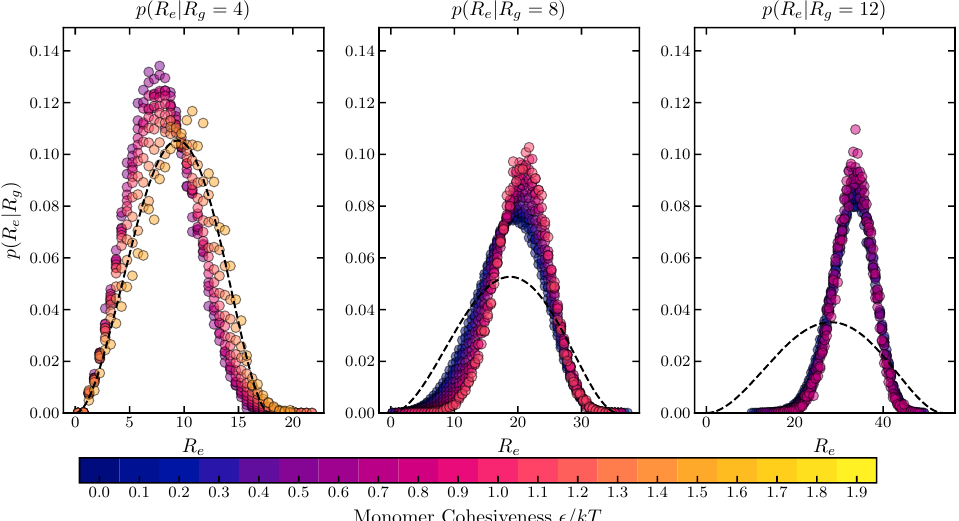
Figure 2. Probability distributions of the end-to-end distance of a homopolymer, conditioned on the sub-ensembles with different radii of gyration. The circle symbols show the simulation results. The color of the symbol (blue to yellow) corresponds to low to high values of (cid:101) . The black dashed line shows the distribution of the end-to-end distance of the Sanchez–Haran model. The number of monomers is N = 100. Polymer dimensions are in the units of diameter. Histogram bin size for calculation of the distribution is 0.5; see Section